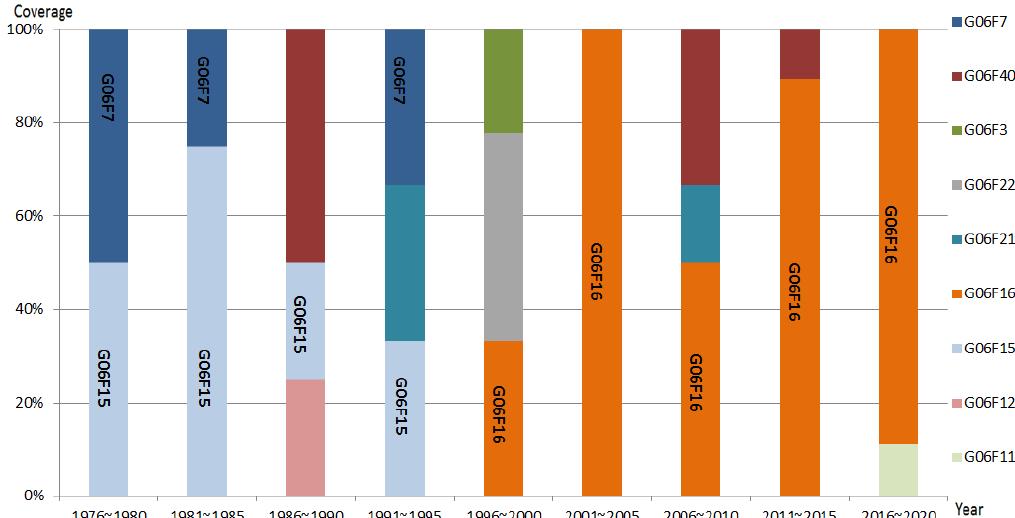
Figure 5. Sub-classification of G06F codes of software patents affecting patents on the main paths of accounting information systems by year.